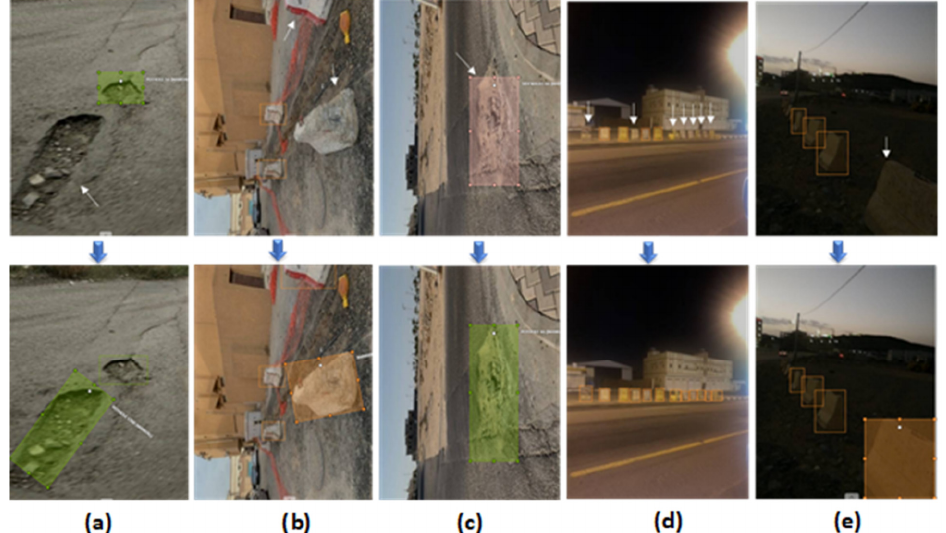
Figure 7. Some examples of the deep active learning (DAL) procedure for image annotation. The first row shows the automatic annotation via a machine during the first round, while the second row depicts the same images but with an expert’s interventions and label corrections. Examples from the three categories of excavation barriers, potholes, and dilapidated sidewalks are shown in numbers ( a – e ).